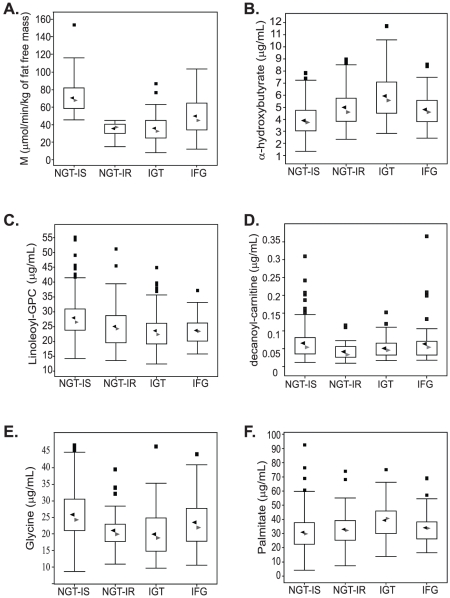
Insulin-mediatedglucose disposal rates and representative metabolite levels in insulin resistant and dysglycemic subjects.A. Box plots of insulin-mediated glucose disposal rates (MFFM, µmol·min−1·kgFFM
−1); derived from the clamp in normoglycemic (NGT) and dysglycemic (IGT, FPG) subjects. B. – F. Box plots of concentrations (µg/ml) of representative metabolites that change significantly with insulin resistance and/or dysglycemia as measured by isotopic dilution assays in subjects with normal glucose tolerance that are insulin sensitive (NGT-IS) or insulin resistant (NGT-IS) and in dysglycemic subjects with impaired glucose tolerance (IGT) or impaired fasting plasma glucose levels (IFG). B. α-HB, C. linoleoyl-GPC, D. decanoyl-carnitine, E. glycine, F. palmitate.